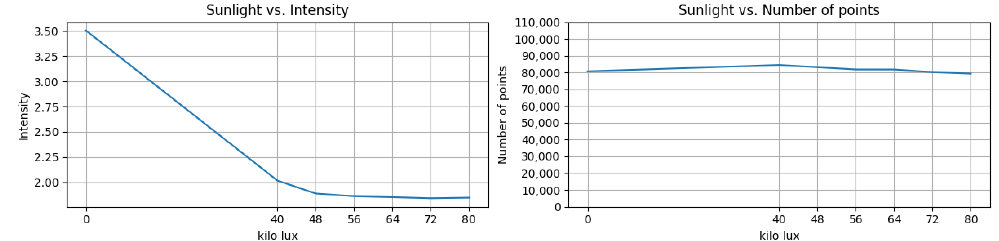
Figure 8. Example of strong sunlight test. The number of points in the reference object and the mean intensity vs. amount of illumination (lux) was plotted in this figure.